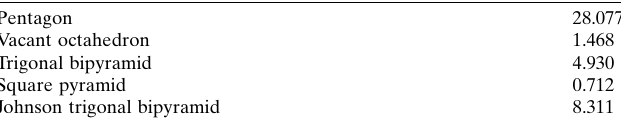
Table 5 Continuous shape measurement (CShM) values ( SHAPE 2.1 ) for the seven-coordinate manganese ion of 2 .